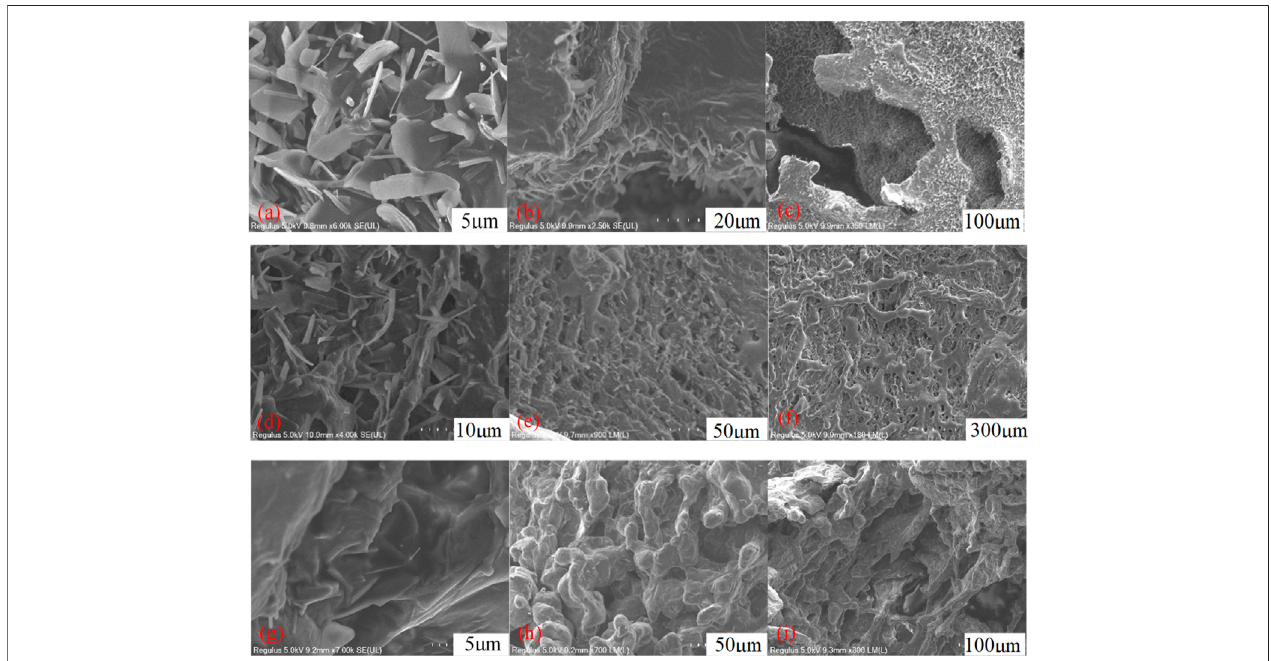
FIGURE 7 | The microstructure of VES-c solution: (A) 0.3% VES-c solution aggregated microstructure; (B) 0.3% VES-c solution layered microstructure; (C) 0.3% VES-c solution overall fl ake and layered microstructure; (D) 1% VES-c solution aggregated microstructure; (E) 1% VES-c solution layered microstructure; (F) 1% VES-c